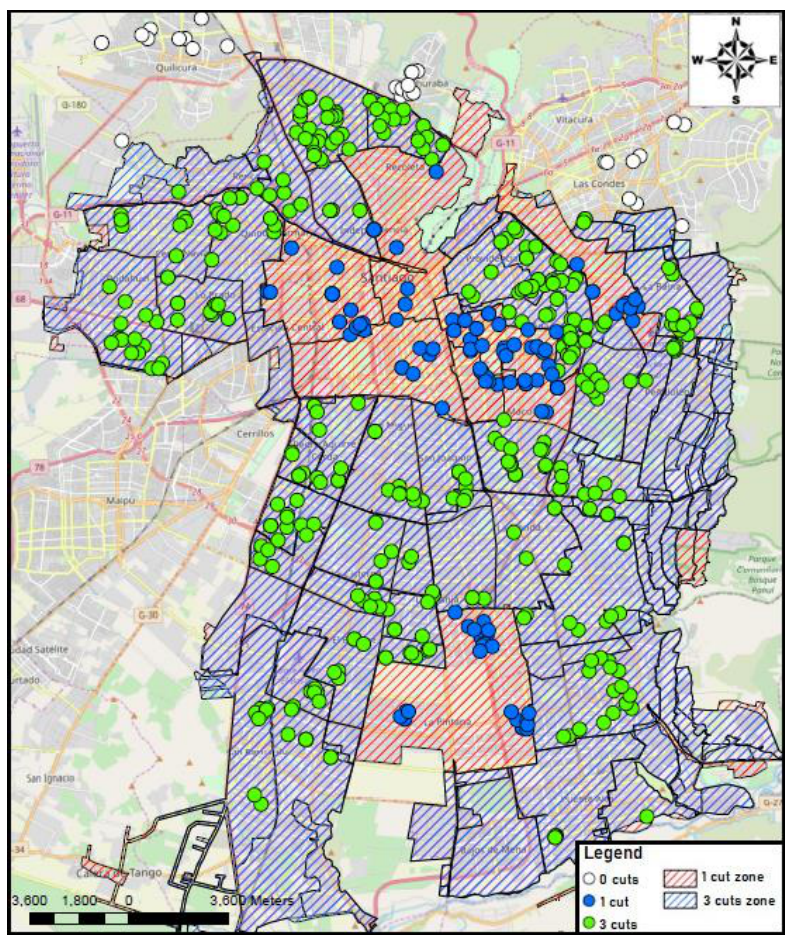
Figure 2. Spatial distribution of surveyed households by the number of water service interruptions.